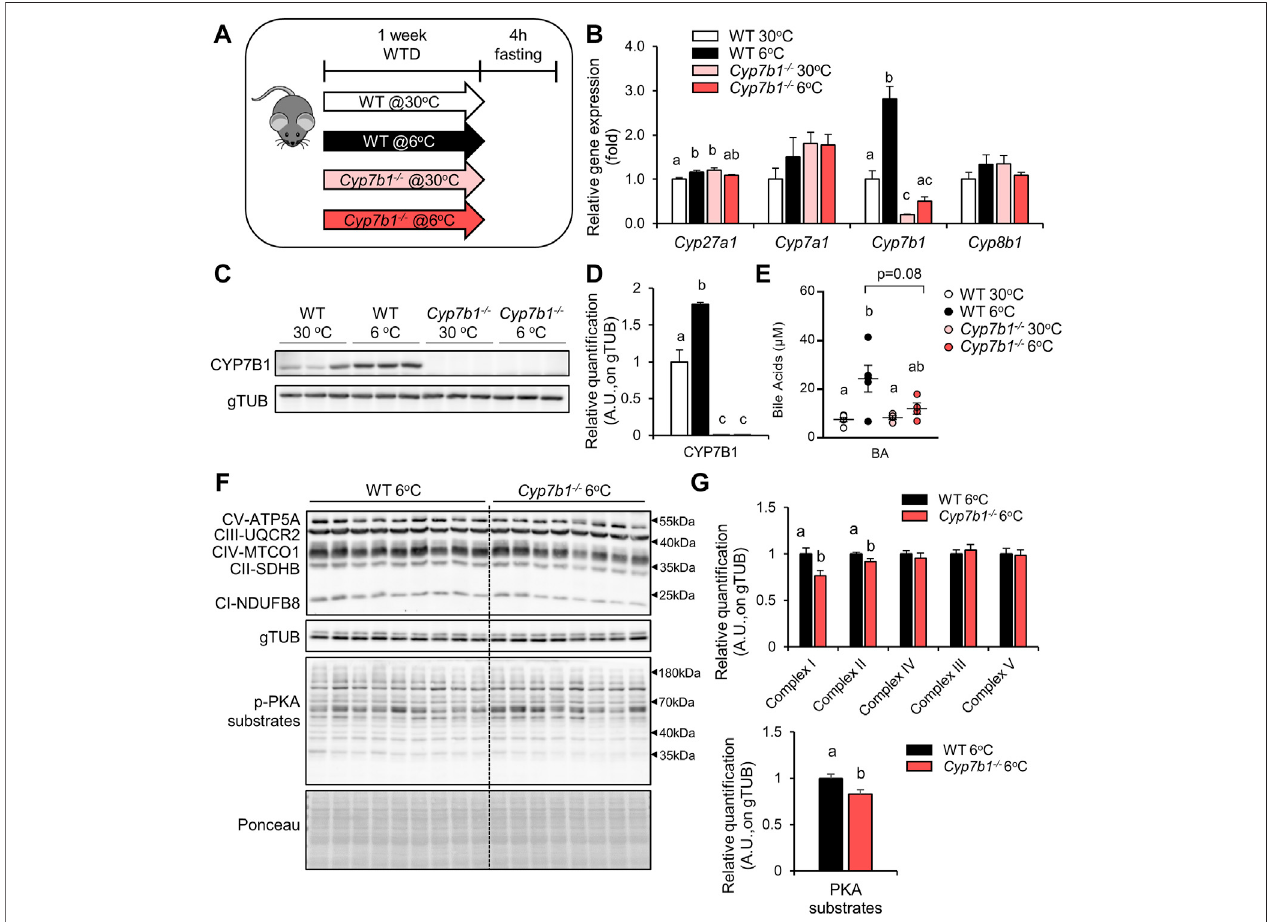
FIGURE 1 | Deletion of Cyp7b1 attenuates the cold-induced bile acid (BA) synthesis and correlates with compromised brown adipose tissue (BAT) responses. Wild-type (WT) and Cyp7b1 − / − littermates were fed a Western-type diet (WTD) and housed for 1 week either at a thermoneutral (30 ° C) or cold (6 ° C) environment. (A) Experimental setup, (B) hepatic gene expression ofbileacidsynthesisgenes,and (C) hepatic protein levels ofCYP7B1 (D) withrelative quanti fi cation and (E) circulating BA levels (n = 3-4/group). (F) Representative Western blotting of OXPHOS complexes and pPKA substrates (G) with relative quanti fi cation of cold-exposed WT (n=9)and Cyp7b1 − / − (n=8)mice.Dataareshownasmeanvalues±SEM.Differentlettersindicatesigni fi cantdifferencesbetweengroups( p < 0.05)determinedbytwo- way